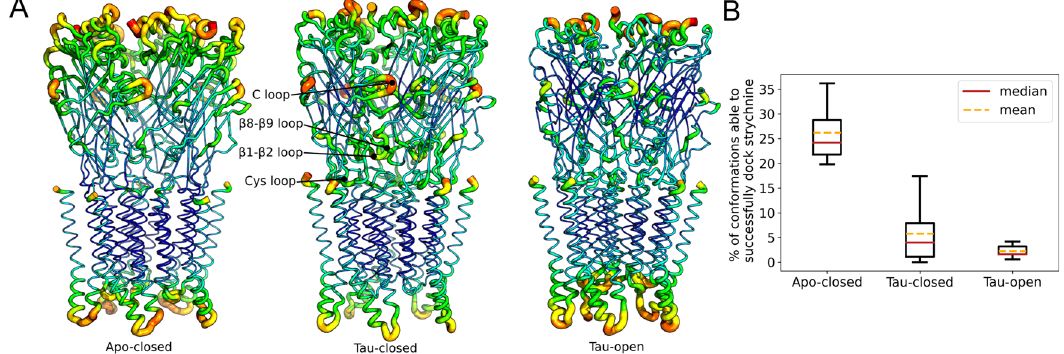
Fig. 7 | Dynamic “ personality ” of the tau-closed state. A Root-mean-square fl uctuations (RMSF) from the average structure extracted from 0.5 µ s MD simula- tions in explicit solvent/membrane are shown for three conformational states of GlyR captured by cryo-EM. Apo-closed corresponds to the resting state and tau- open to the active state of the receptor. For each state, RMSF values ranging from 0.5to4.5Åareshownbythecolor(frombluetored)andthethickness(fromthinto thick) of the sausage representation ( B ). State-based docking of strychnine. The boxplot de fi nes the center at the median (red line) and mean (yellow dashed line),